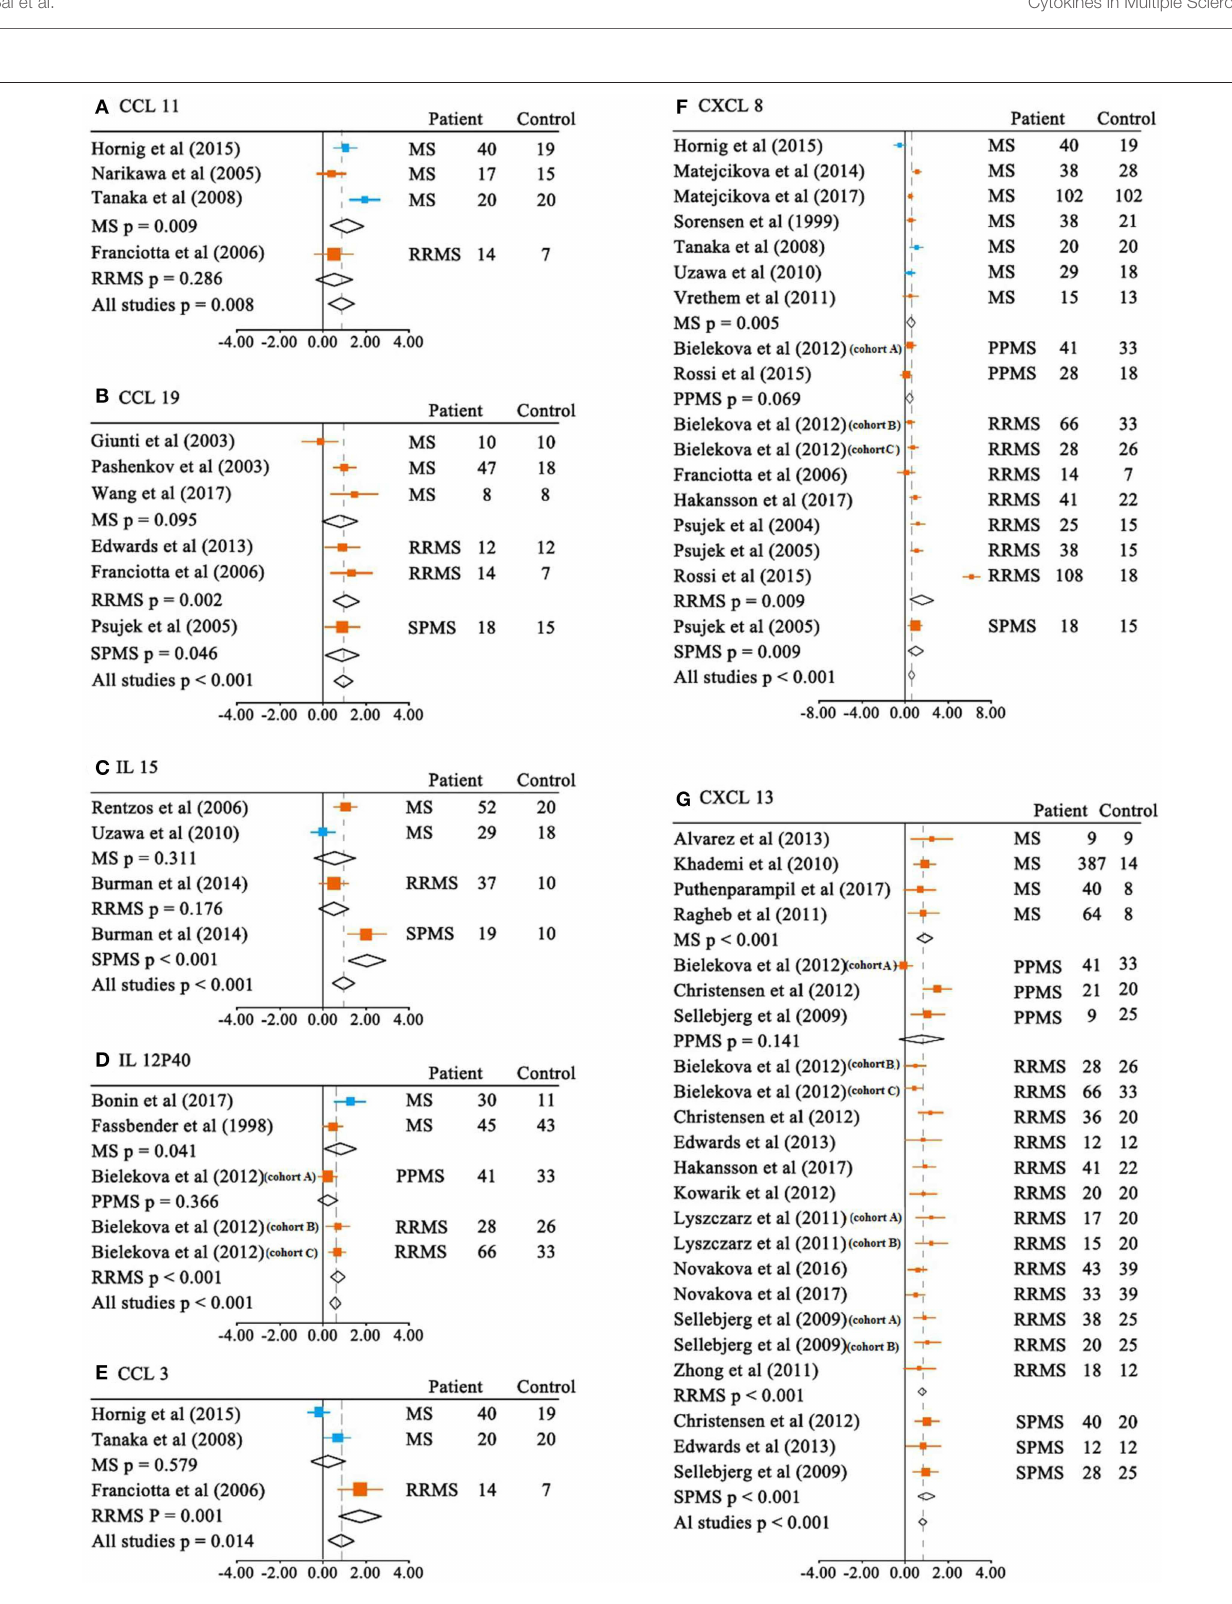
FIGURE 3 | Multiple sclerosis to control SMD for CSF cytokines. CSF SMDs of CCL11 (A) , CCL19 (B) , IL-15 (C) , IL-12P40 (D) , CCL3 (E) , CXCL8 (F) , CXCL13 (G) between multiple sclerosis and controls. ELISA; non-ELISA.